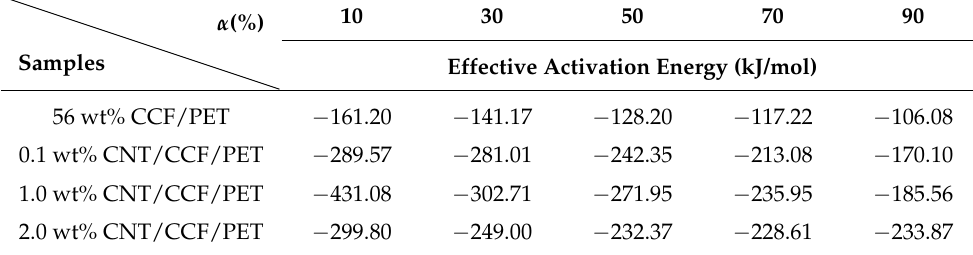
Table 7. The effective activation energy of CNT/CCF/PET with different CNT content by Friedman